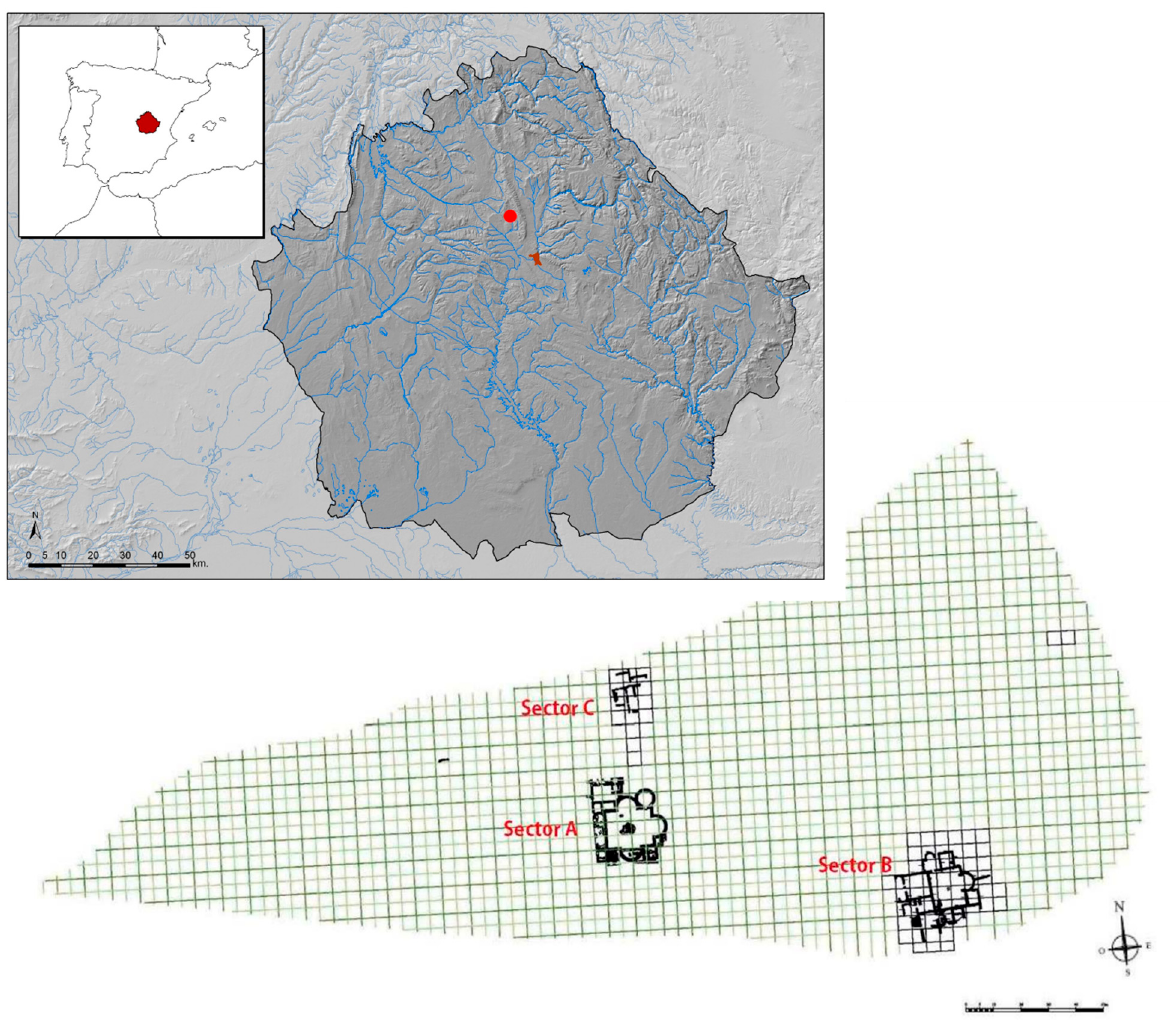
Figure 1. Location of the settlement (red dot) within Cuenca Province, and planimetry of the Roman villa of Noheda, indicating the archaeological sectors.